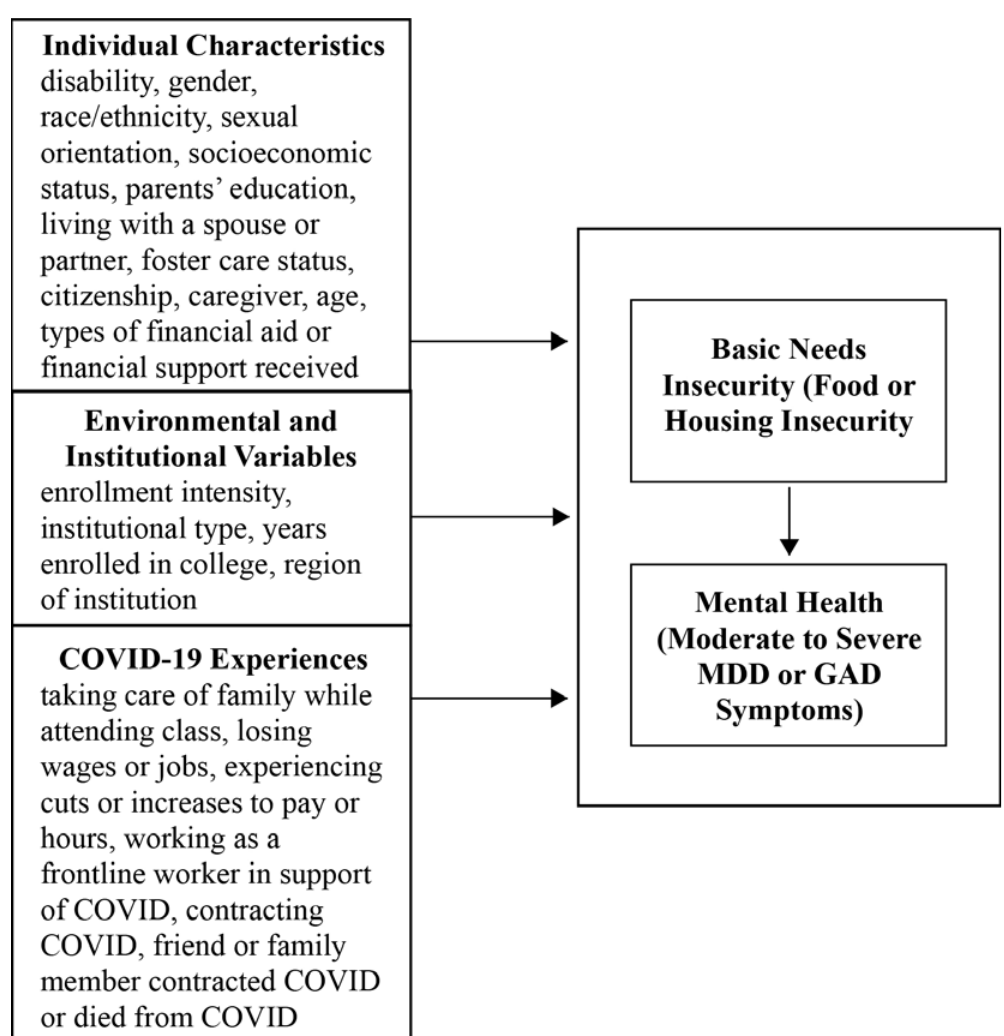
Figure 1. Conceptual Framework for College Students’ Basic Needs Insecurity and Mental Health During the COVID- 19